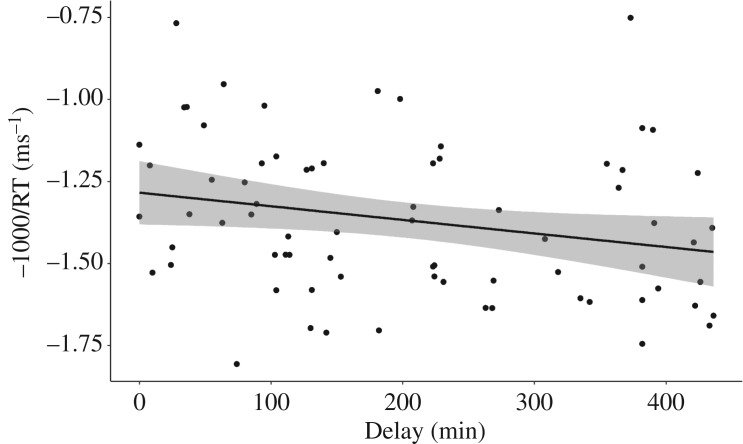
Speeded recognition mean inverse reaction time at re-test correlated with Delay collapsed across Exposure conditions. As Delay gets longer, RTs get faster.